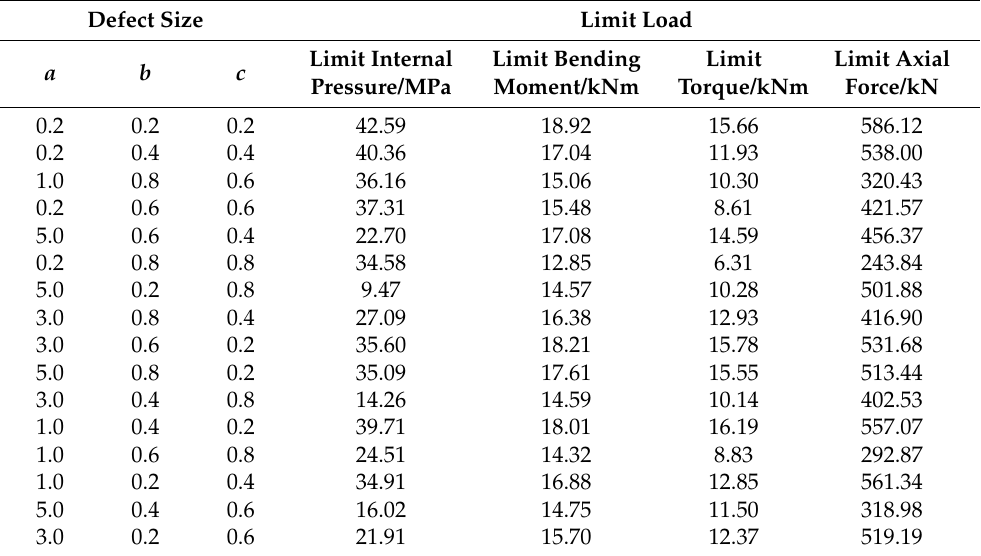
Table 6. The calculation results of the limit load of straight pipes with local wall-thinning defects under single